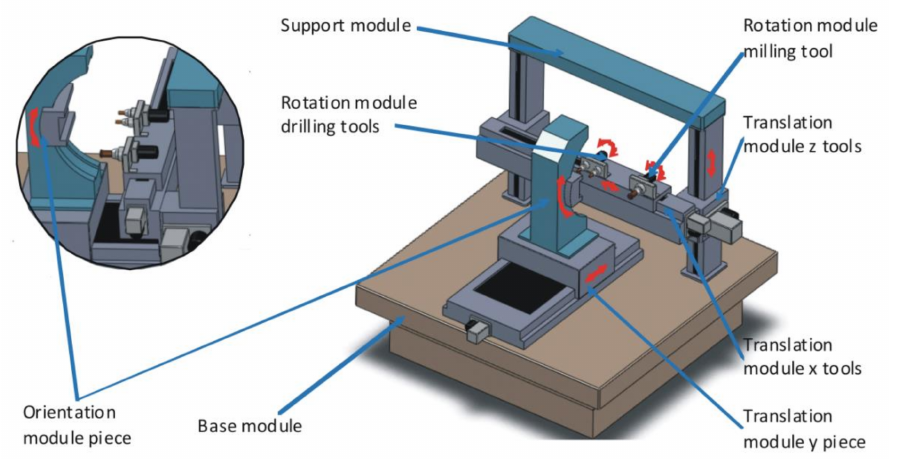
Figure 6. Particle 1 at iteration 2: variant